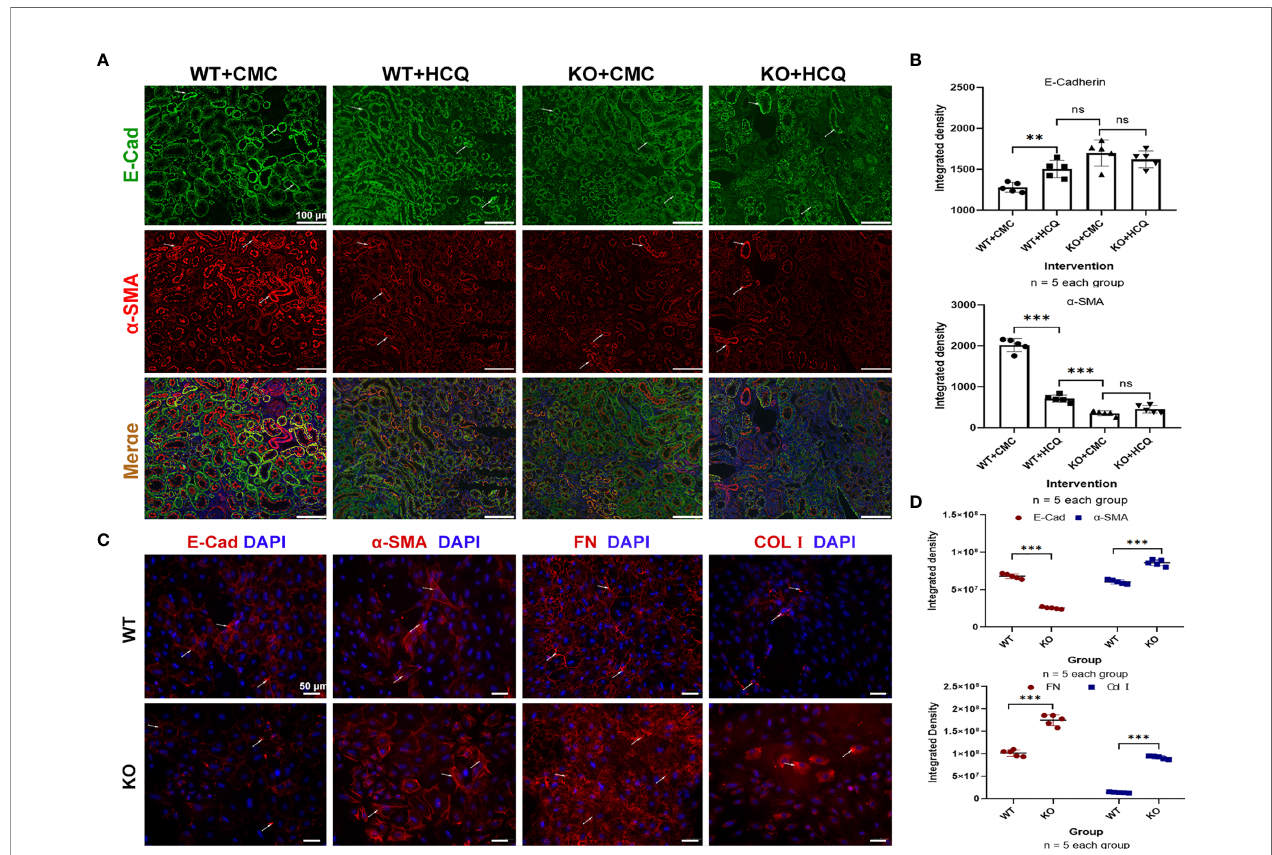
FIGURE 7 | TLR-9 signal pathway did not contribute to the improvement of EMT in vitro . (A) First row: representative fl uorescence microscope images of E-Cad (Green), a -SMA (Red), and DAPI (Blue) staining of the kidneys of WT and KO mice that were treated with CMC or HCQ following reperfusion; the scale bars represent 100 m m.; (B) Semiquantitative analysis of E-Cad and a -SMA immuno fl uorescence staining. (C) Immuno fl uorescence of COL I, FN, E-Cad, and a -SMA was used to assess fi brosis and EMT of RTECs after being exposed to TGF- b (10 ng/ml) for 72 h; the scale bars represent 100 m m. (D) Semiquantitative analysis of E- Cad, a -SMA, FN, and COL I immuno fl uorescence staining of RTECs following TGF- b treatment. Data are shown as means ± SD and analyzed using one-way analysis of variance or Student ’ s t test. Each dot represents an individual assay. Magni fi cation: 200×. NS, no signi fi cant difference; **P < 0.01, ***P < 0.001. EMT, epithelial-to-mesenchymal transition; RTECs, renal tubular epithelial cells; WT, wild-type; KO, knockout; E-Cad, E-cadherin; a -SMA, a -smooth muscle; COL I, collagen I; FN, fi